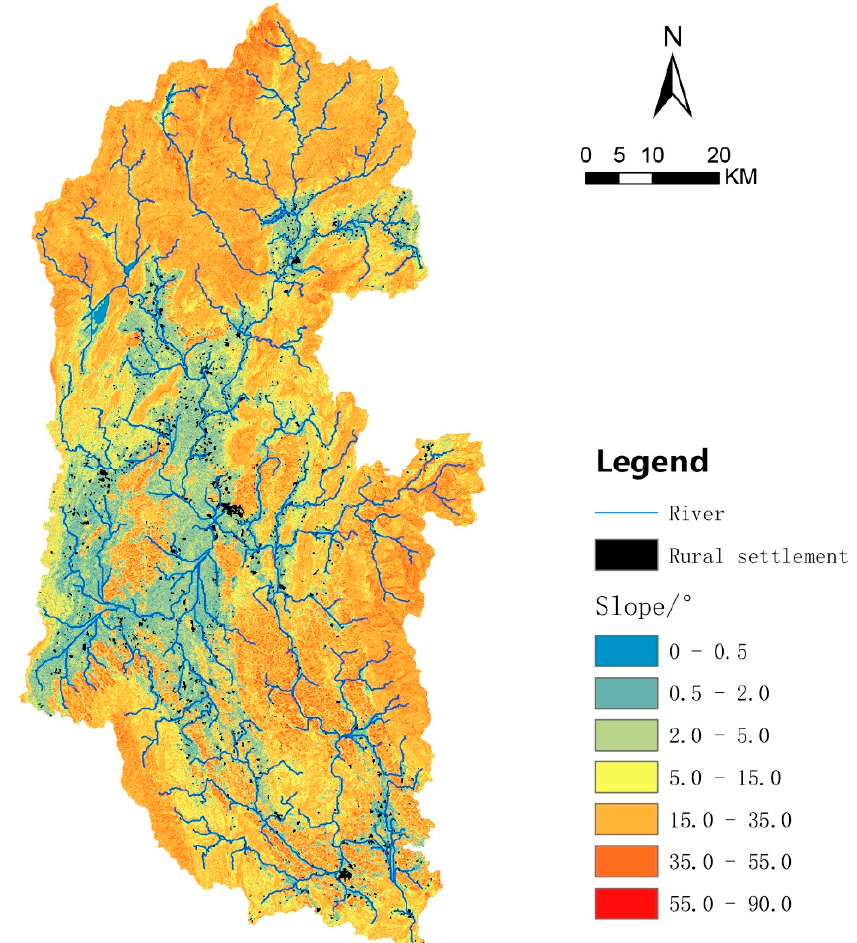
Figure 6. Slope map of rural settlement distribution in the Lijiang River Basin. Black spots indicate rural settlements.